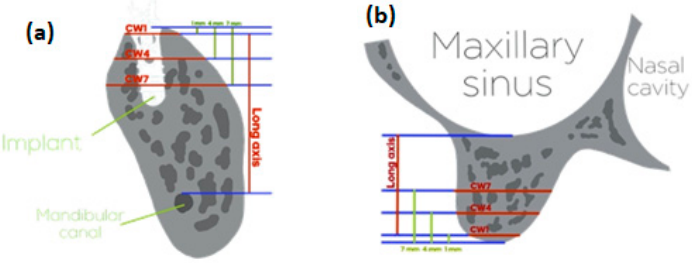
Figure 2. Schematic diagram of the measurement of alveolar bone width at the ( a ) mandible and ( b ) maxilla.